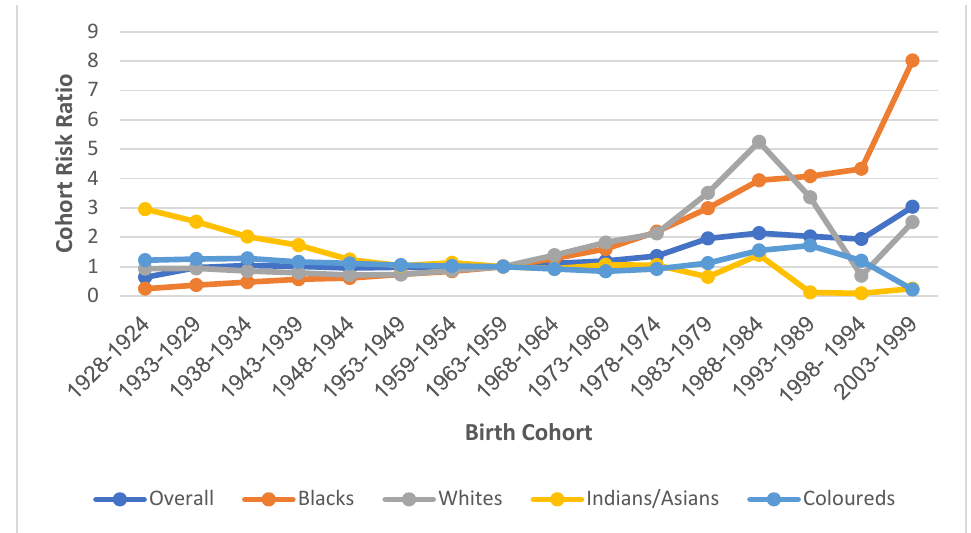
Figure 7. Cohort Risk ratio of the National and ethnic cervical cancer mortality trends in South Africa